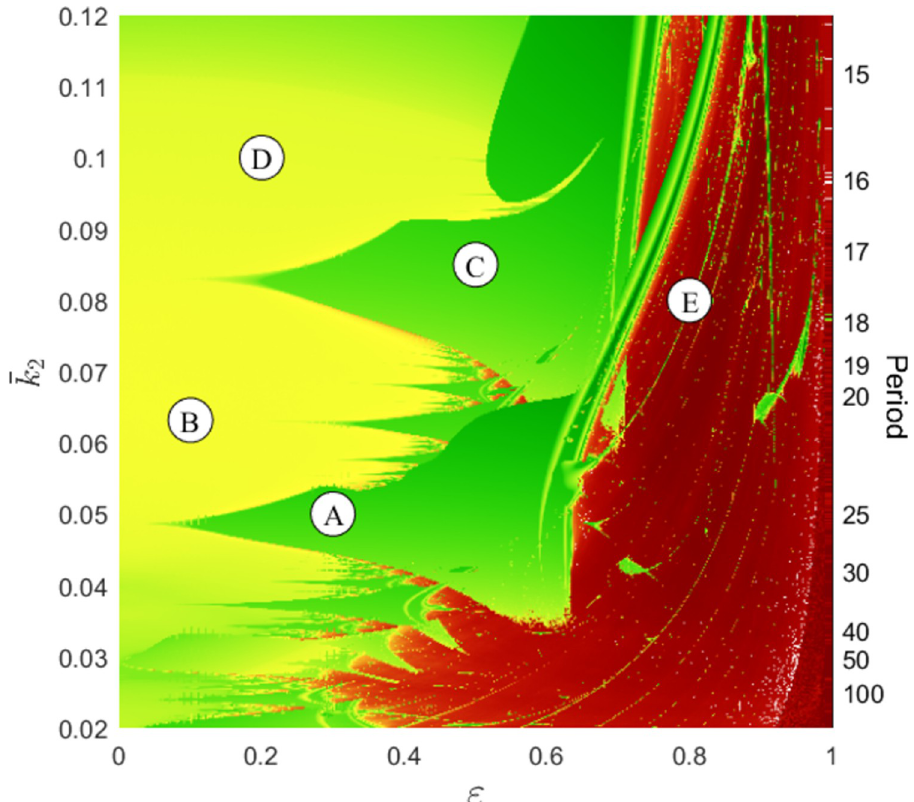
Fig 21. In the red regions the stalemate is chaotic because the Lyapunov exponent is positive. In the yellow regions the stalemate is quasi-periodic and in the green regions it is periodic. On the vertical axis (i.e., when there are no seasons) the stalemate is periodic and its period (in weeks) is indicated on the right of the figure. Points A—E correspond to conflicts whose time series are reported in (see Fig A5.1 and Appendix 5 in S1 File).